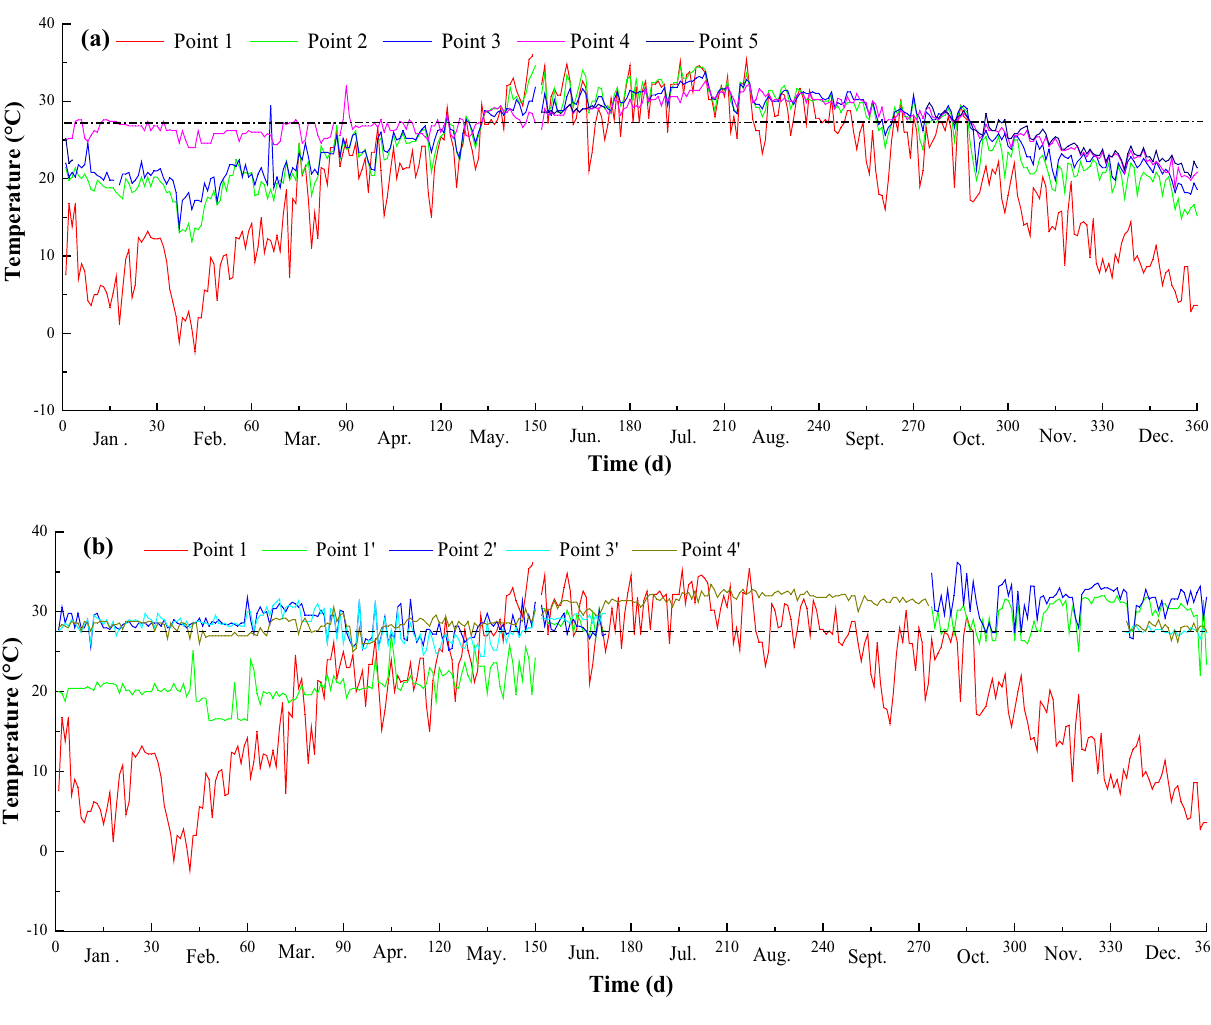
Fig. 4 Temperature changes in the a intake ventilation routes and the b return ventilation routes Table 2 Correlations between surface air temperatures and temper- atures recorded at underground MPs Location Correlation coefficient Correlation